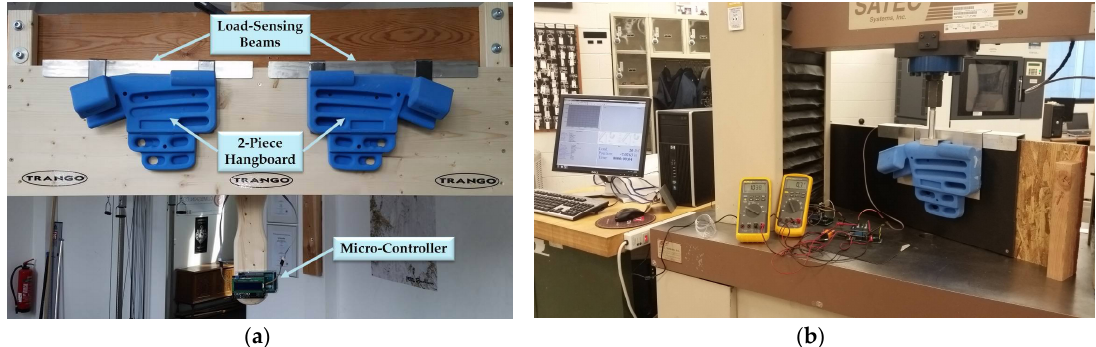
Figure 1. ( a ) The Force Board system indicating the component parts. This installations is in Kafe Craft